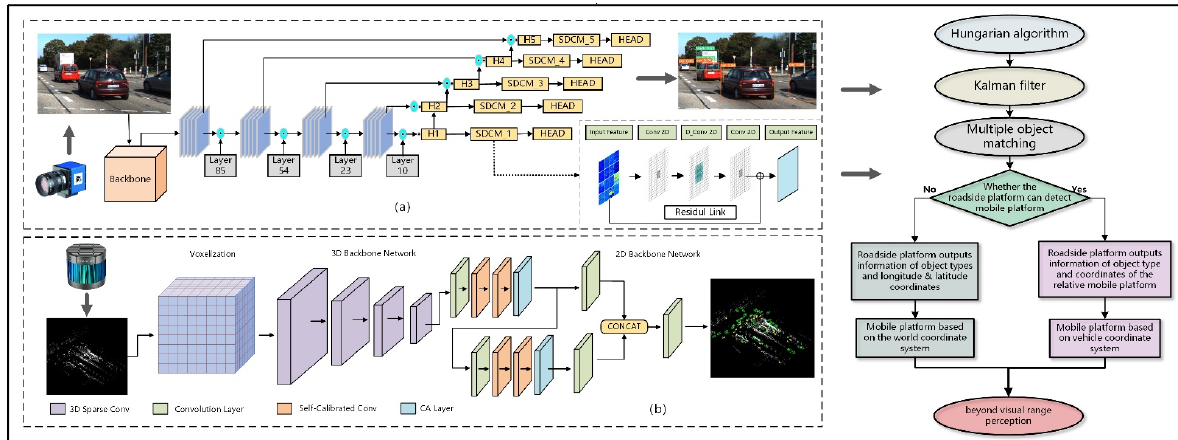
Figure 1. Structure of vehicle-to-infrastructure beyond visual range cooperative perception algorithm, ( a ) structure of 2D multi-object detection algorithm, ( b ) structure of 3D multi-object detection algorithm